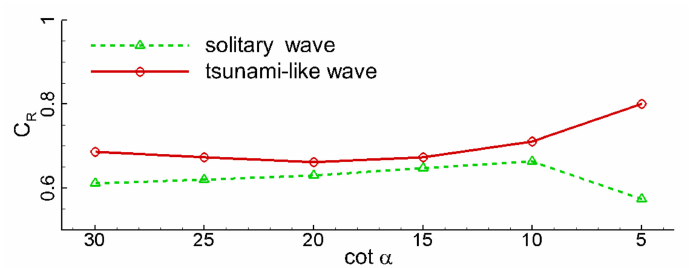
Figure 32. Variations in maximum runup height of overtopping water surge bores with different beach slopes.